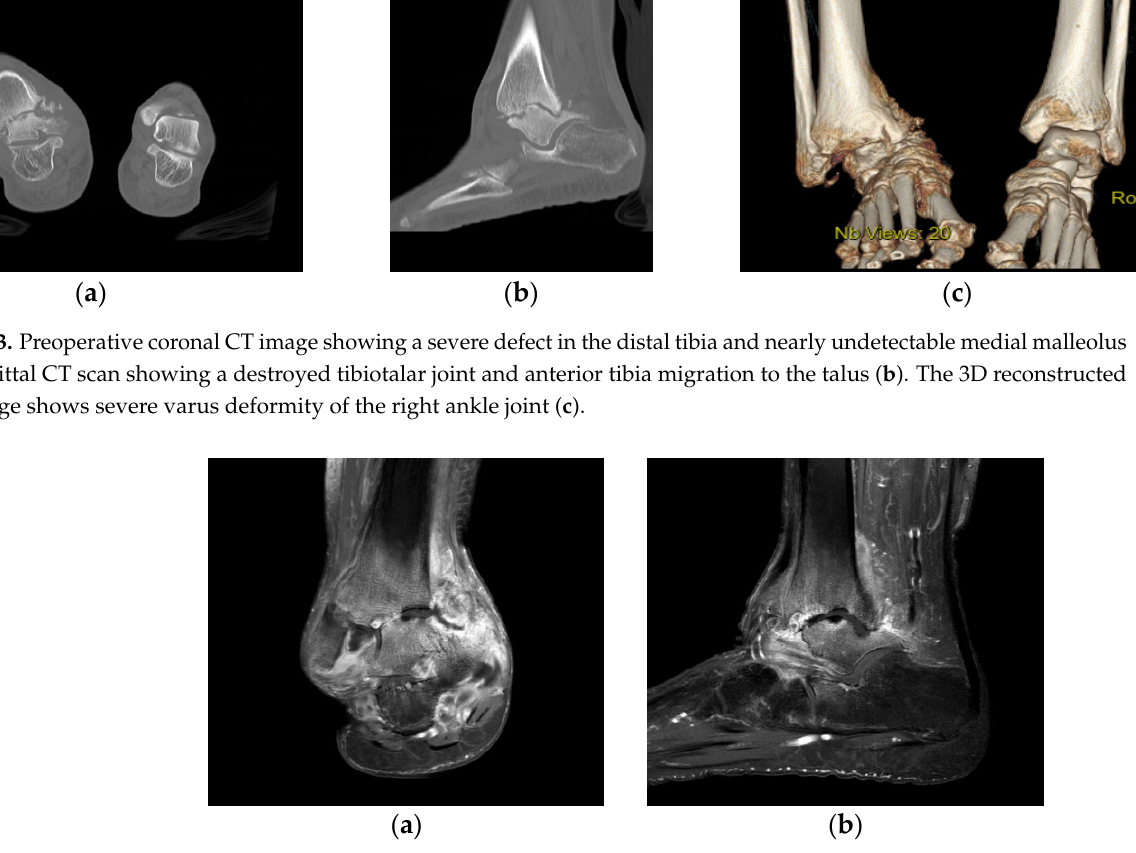
Figure 4. Preoperative T2-weighted coronal ( a ) and sagittal ( b ) magnetic resonance images showing a septic ankle joint with diffuse synovial thickening, increased joint effusion with surrounding soft tissue swelling of the distal tibia, and talus osteomyelitis.